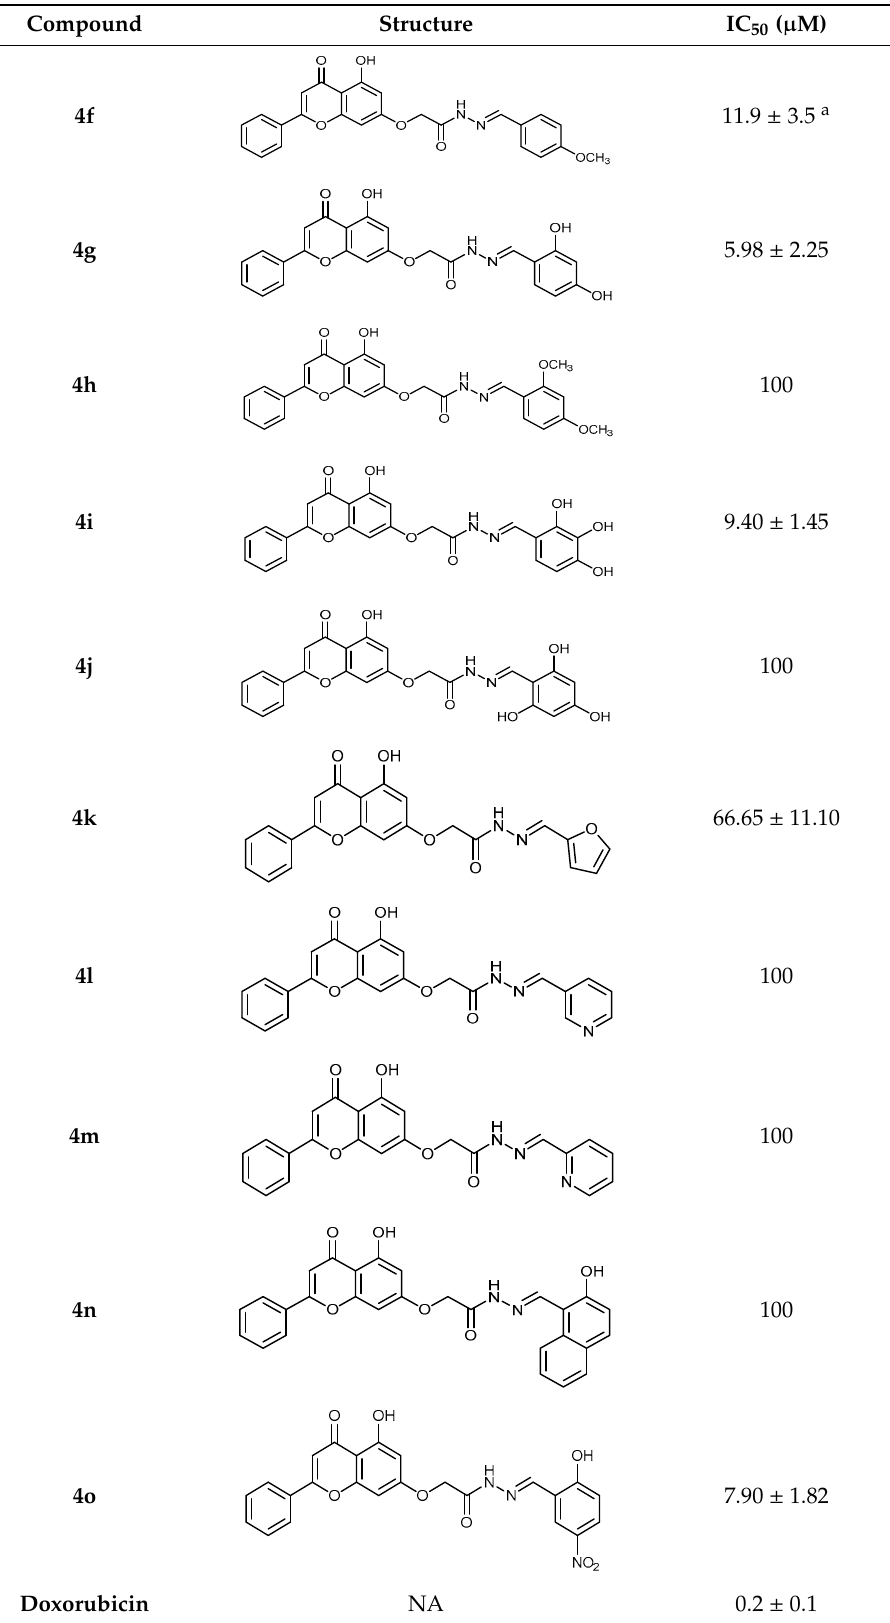
Table 2. The effects of chrysin derivatives ( 4a – 4o ) on the survival of the MDA-MB-231 cancer cell line.